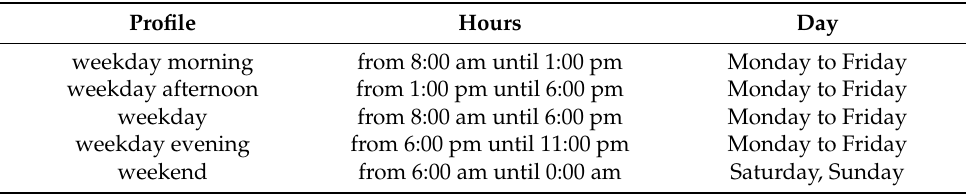
Table 4. Vehicle-to-Home usage profile: periods in which the vehicle is off home.